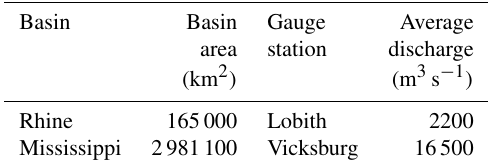
Table 1. Basin characteristics of the two study basins, including basin area, used gauge station, and its average discharge